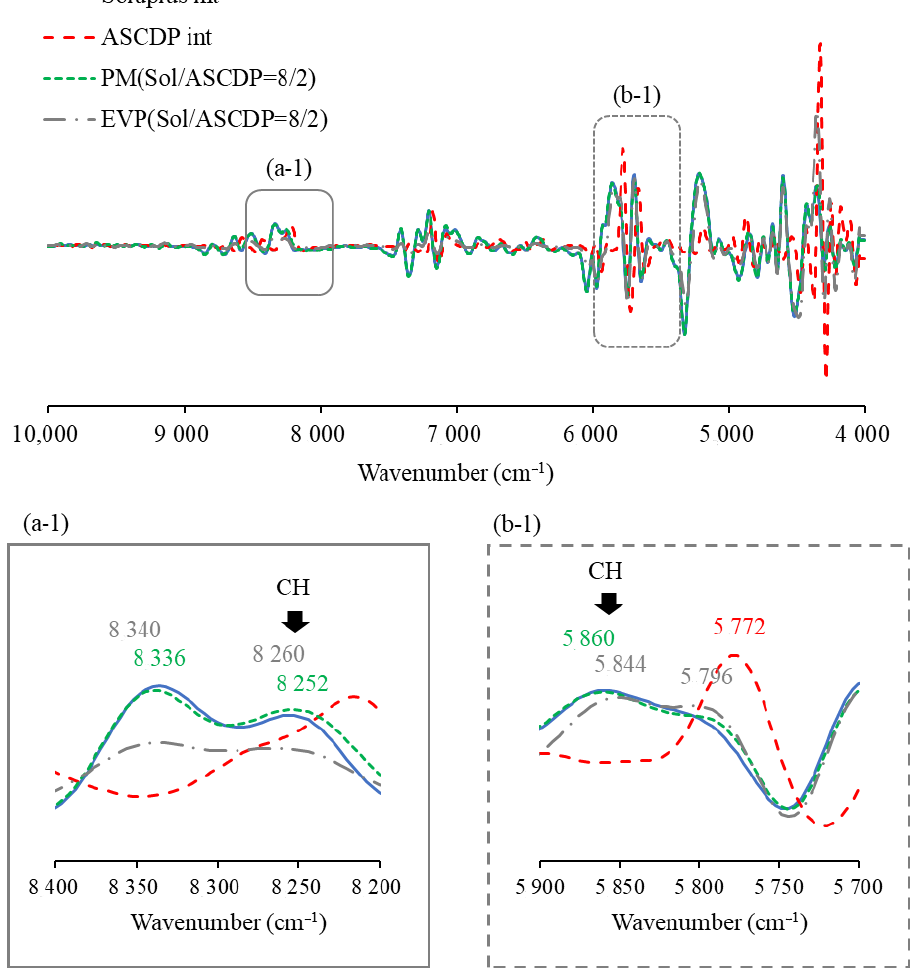
Figure 9. Second-differentiation NIR absorption spectra of Sol/ASC-DP systems. (a-1) 8400–8200 cm − 1 , (b-1) 5900–5700 cm −1.